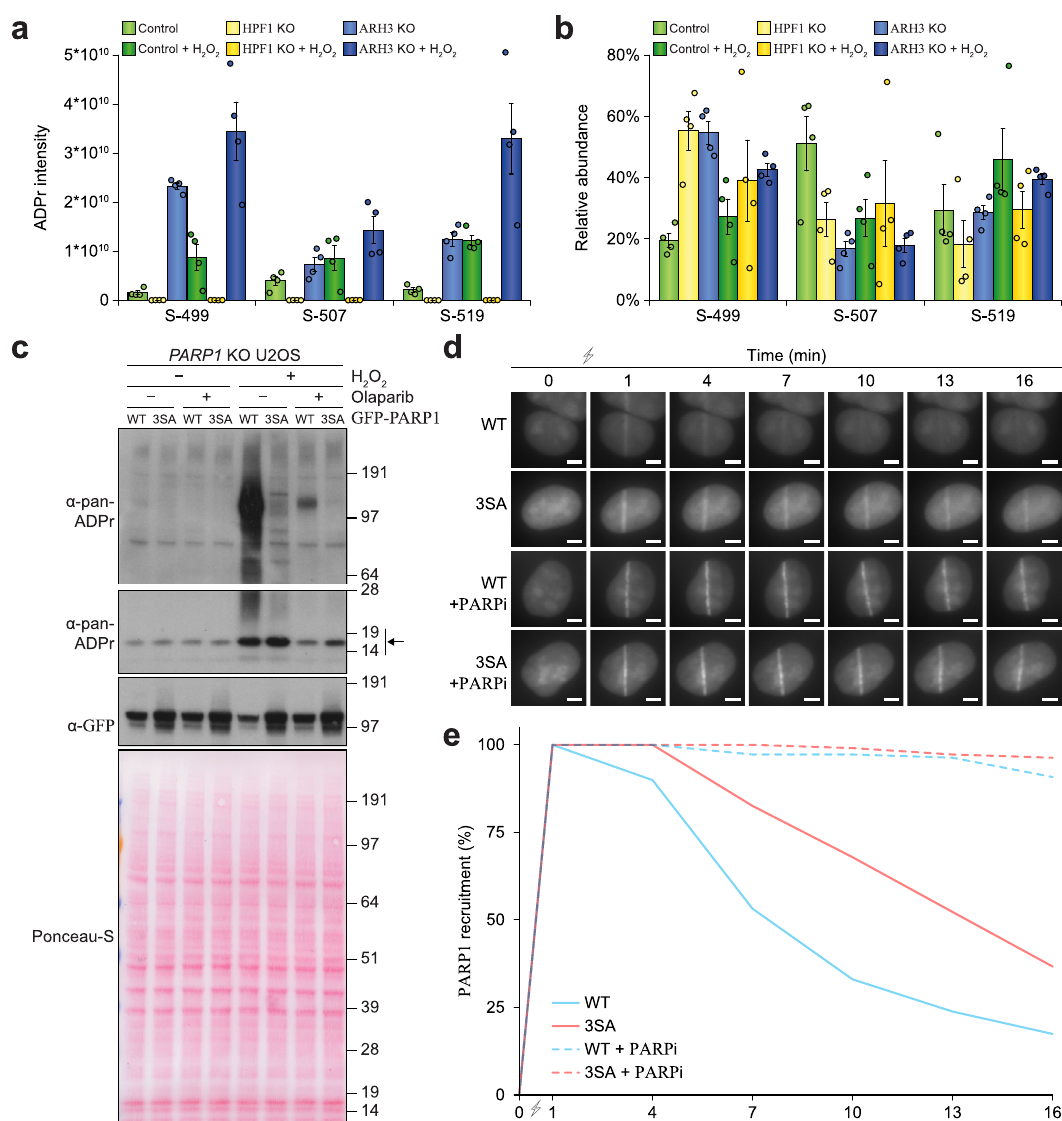
Fig. 6 Mutational analysis of PARP1 serine auto-modi fi cation. a PARP1 auto-modi fi cation analysis, showing absolute modi fi cation abundance. n = 4 cell culture replicates, data are presented as mean values± SEM. b As a , but showing relative modi fi cation abundance. c Immunoblot analysis highlighting the ADPr equilibrium in PARP1 wildtype (WT) and 3SA mutant cells, ±Olaparib pre-treatment at 10 μ M for 1 h ( “ PARPi ” ), ± H 2 O 2 treatment at 5 mM for 30 min. The arrow indicates histone ADPr. This experiment was performed as two independent biological replicates, with similar results. d Representative live-cell microscopy images, visualizing GFP-PARP1 recruitment following laser microirradiation. The scale bar represents 5 μ m. e Quanti fi cation of recruitment kinetics of GFP-PARP1 to damage stripes, as monitored via full visual dissipation of accumulated PARP1 signal. Strati fi cation classes and all strati fi ed data are available in Supplementary Fig. 5. PARP1 kinetics were signi fi cantly different between WT and 3SA mutant in the absence of PARPi, at p = 1.0 × 10 − 5 for T = 1, p = 1.0 × 10 − 5 for T = 4, p = 7.9 × 10 − 5 for T = 7, p = 1.0 × 10 − 5 for T = 10, p = 2.4 × 10 − 4 for T = 13, and p = 0.017 for T = 16, as determined via chi-squared testing on all strati fi ed data (Supplementary Fig. 5B). n = 109 cells per condition. Source data are provided as a Source Data fi